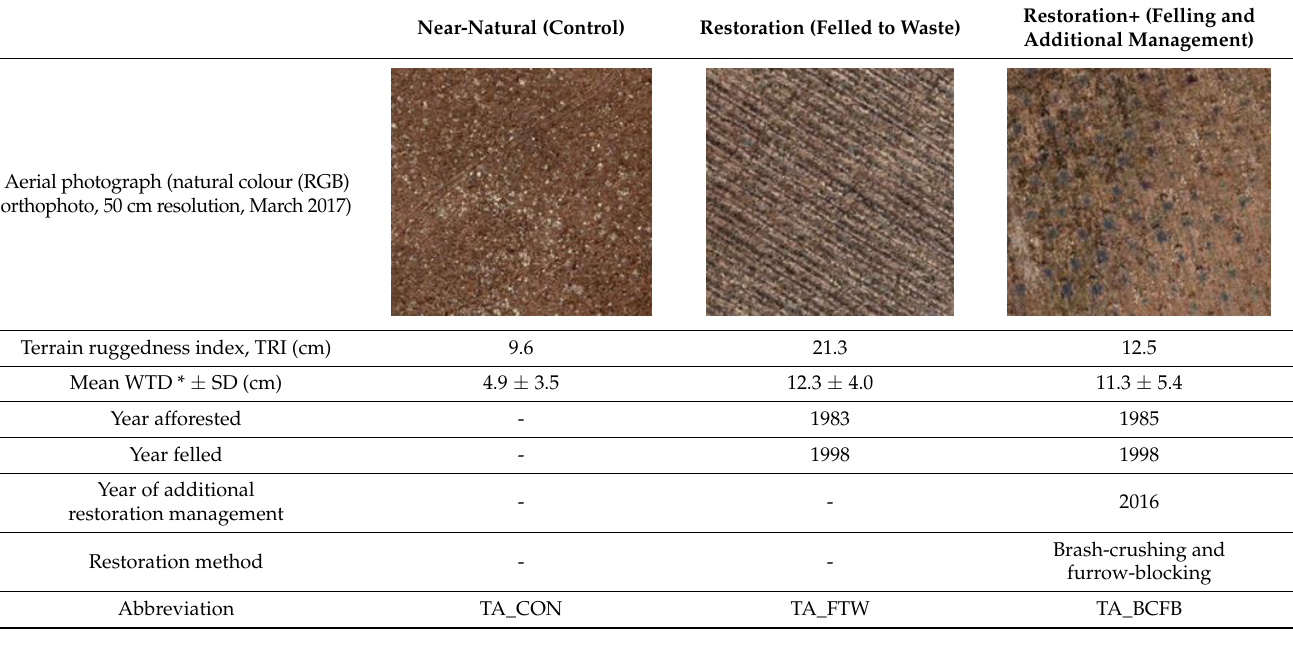
Table 1. Forsinard Flows Talaheel site’s characteristics. * Mean water table depth between 15 Sep-